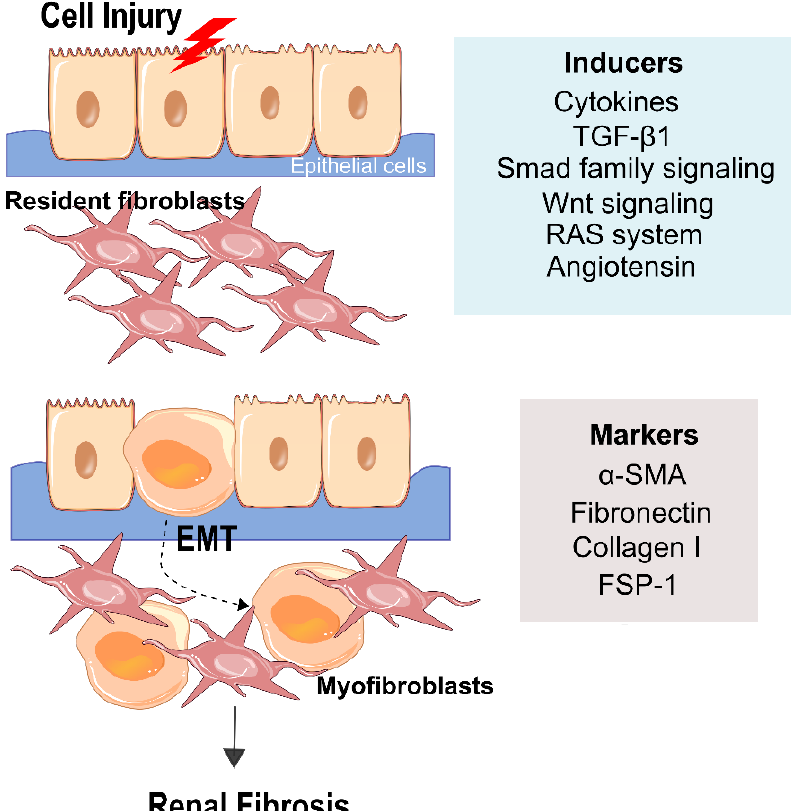
Figure 1. Epithelial and Mesenchymal transition. After injury, epithelial cells suffered a process called epithelial-mesenchymal transition (EMT), in which cells start expressing mesenchymal markers rather than epithelial markers. A wide number of factors have been pointed to as a potentiator of tubular EMT. The most potent inducer is Transforming growth factor-beta 1 (TGF- β 1). Furthermore, signaling pathways that cooperate with TGF- β 1 are also considered to be important mediators for EMT and consequently to renal fibrosis, such as Smad family, Renin-angiotensin system (RAS), and Wnt/ β -catenin signaling. EMT is a highly coordinated process, characterized by the loss of cell-cell contact leading to cellular destabilization. Then, there is a de novo expression of mesenchymal proteins, such as α -SMA, and where it produced extracellular matrix proteins, including fibronectin, collagen I, and Fibroblast-specific protein 1 (FSP-1.) In the last phase of EMT, fibroblasts are activated and called myofibroblasts. These myofibroblasts share the same place that resident fibroblasts, whose proliferation is increased. This accumulation in the interstitium between tubules culminates in tubulointerstitial